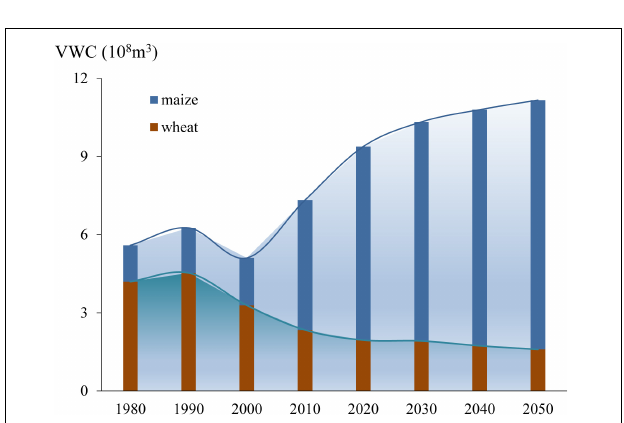
FIGURE 7 | Virtual water content of crops ( V WC c ) in Zhangye during